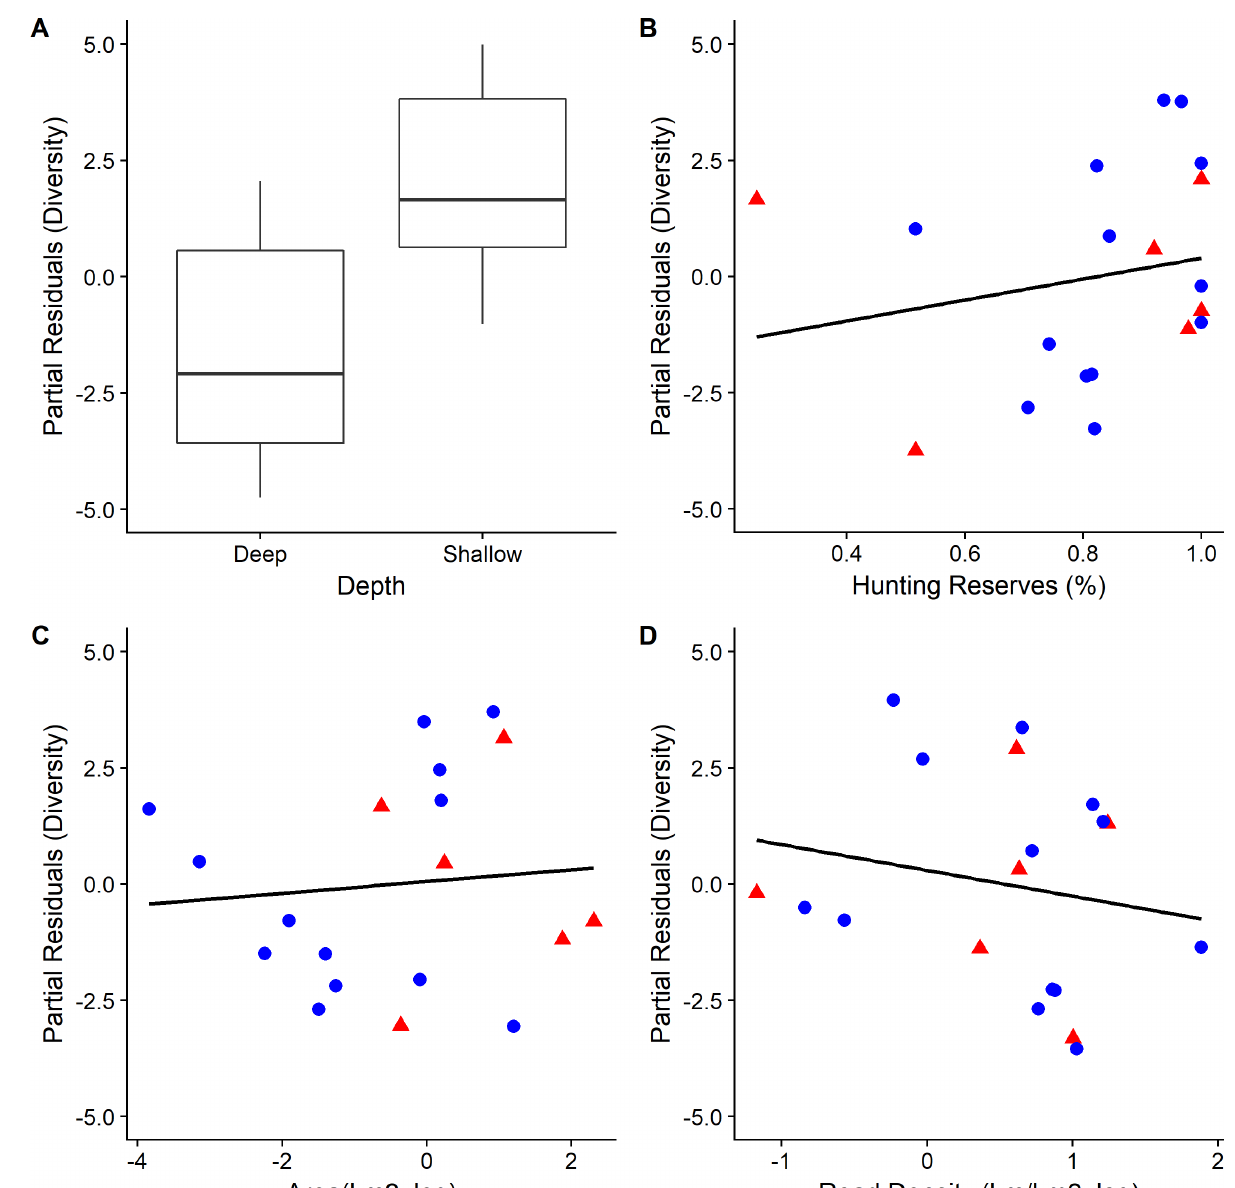
Fig 5. Partial residual plots illustrating the relationship between each of the four explanatory variables and species diversity (Fisher’s alpha diversity) in year 2011. Blue circles ( ● ) correspond to artificial wetlands and red triangles ( ▲ ) to natural wetlands. Boxplots are based on the median and the 1 st and 3 rd